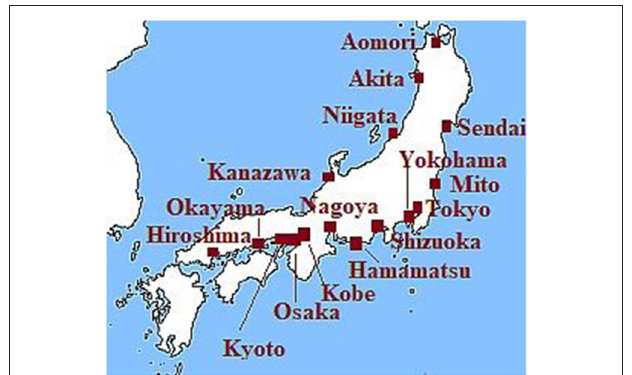
FIGURE 1 | Map of Japan.